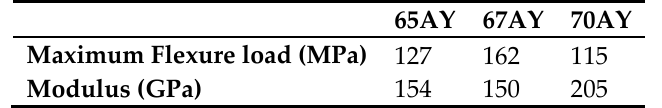
Table 2. Flexural properties of Al 2 O 3 -YAG (65AY, 67AY and 70AY) oxide ceramic